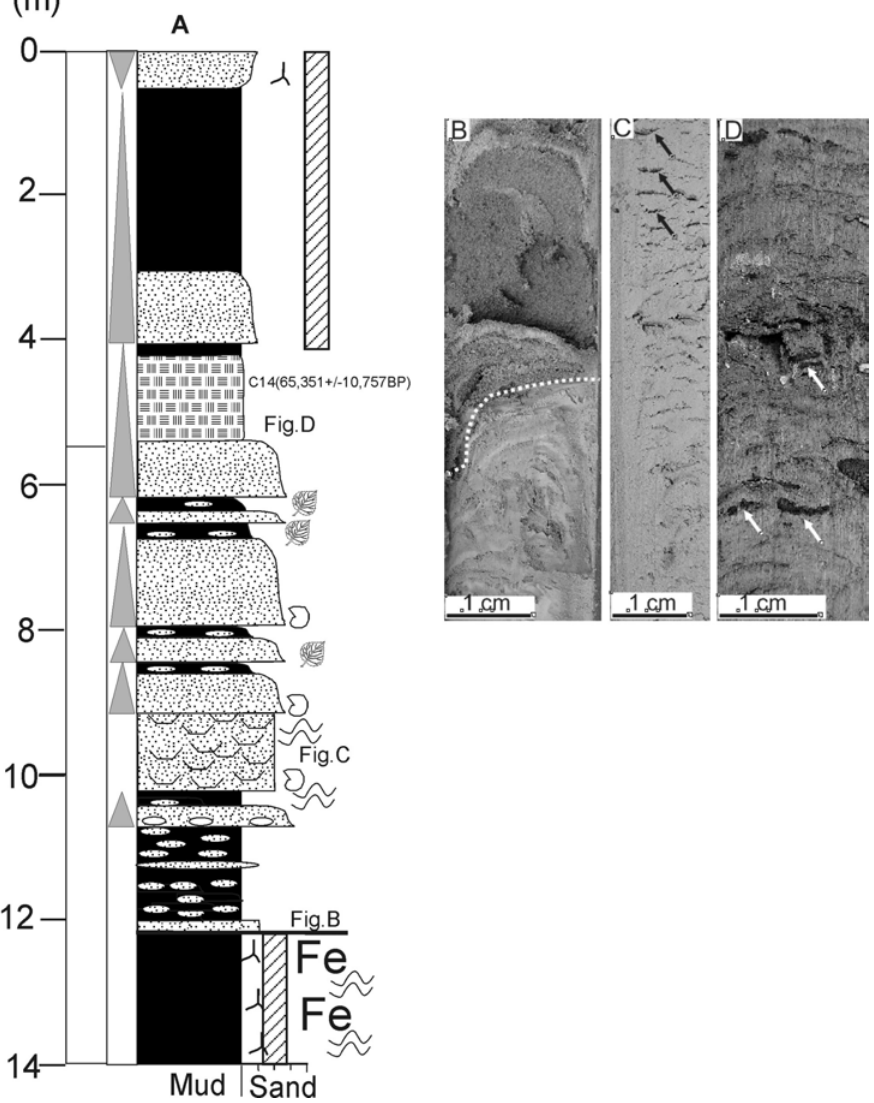
Fig. 5 – Drill #3 (flood plain). A) Lithostratigraphic profile illustrating facies characteristics and vertical facies distribution. B) Detail of the sharp, erosive contact at 12 m depth, which separates endured massive muds, below, from massive sands, above. C) Sand with dish structures (arrows) from depth = 12 m. D) Detail of pit deposits that occur in association with mud deposits from the fining upward cycle located between 4.1 and 6.2 m of depth (arrows indicate larger plant fragments). (See Figure 2 for drill